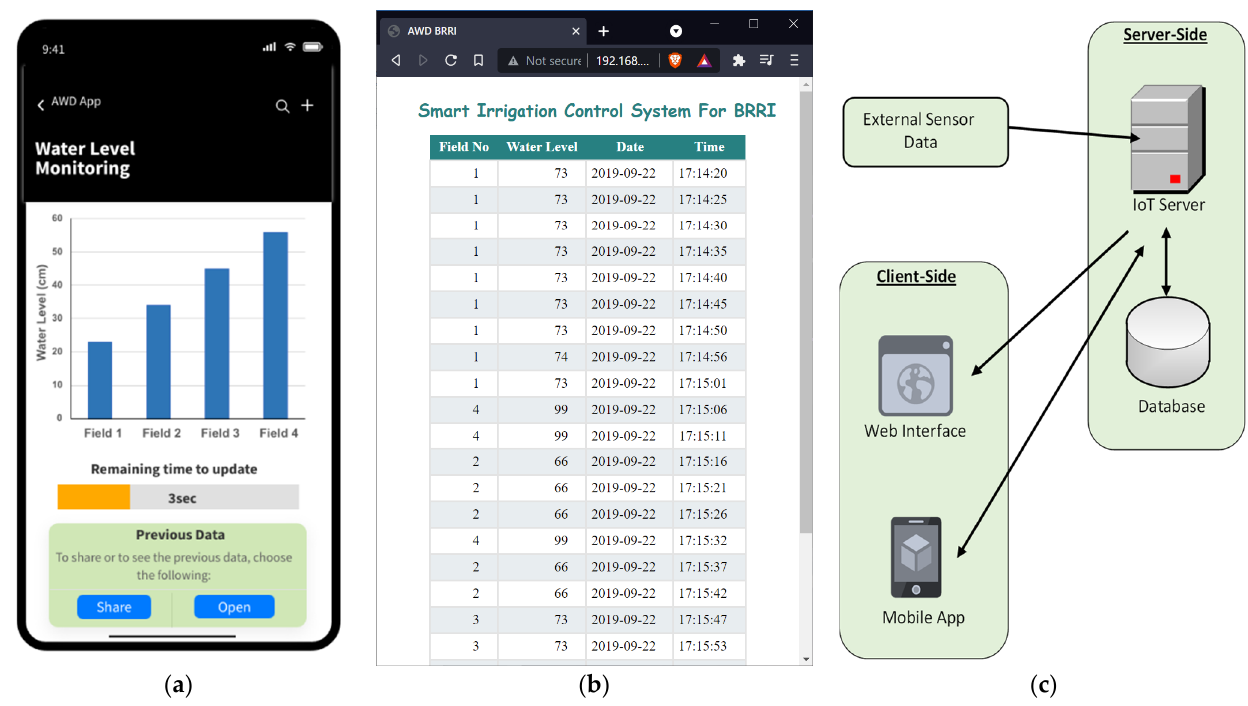
Figure 12. ( a ) Mobile Application, ( b ) Web Application, and ( c ) client-server connectivity for user interface.